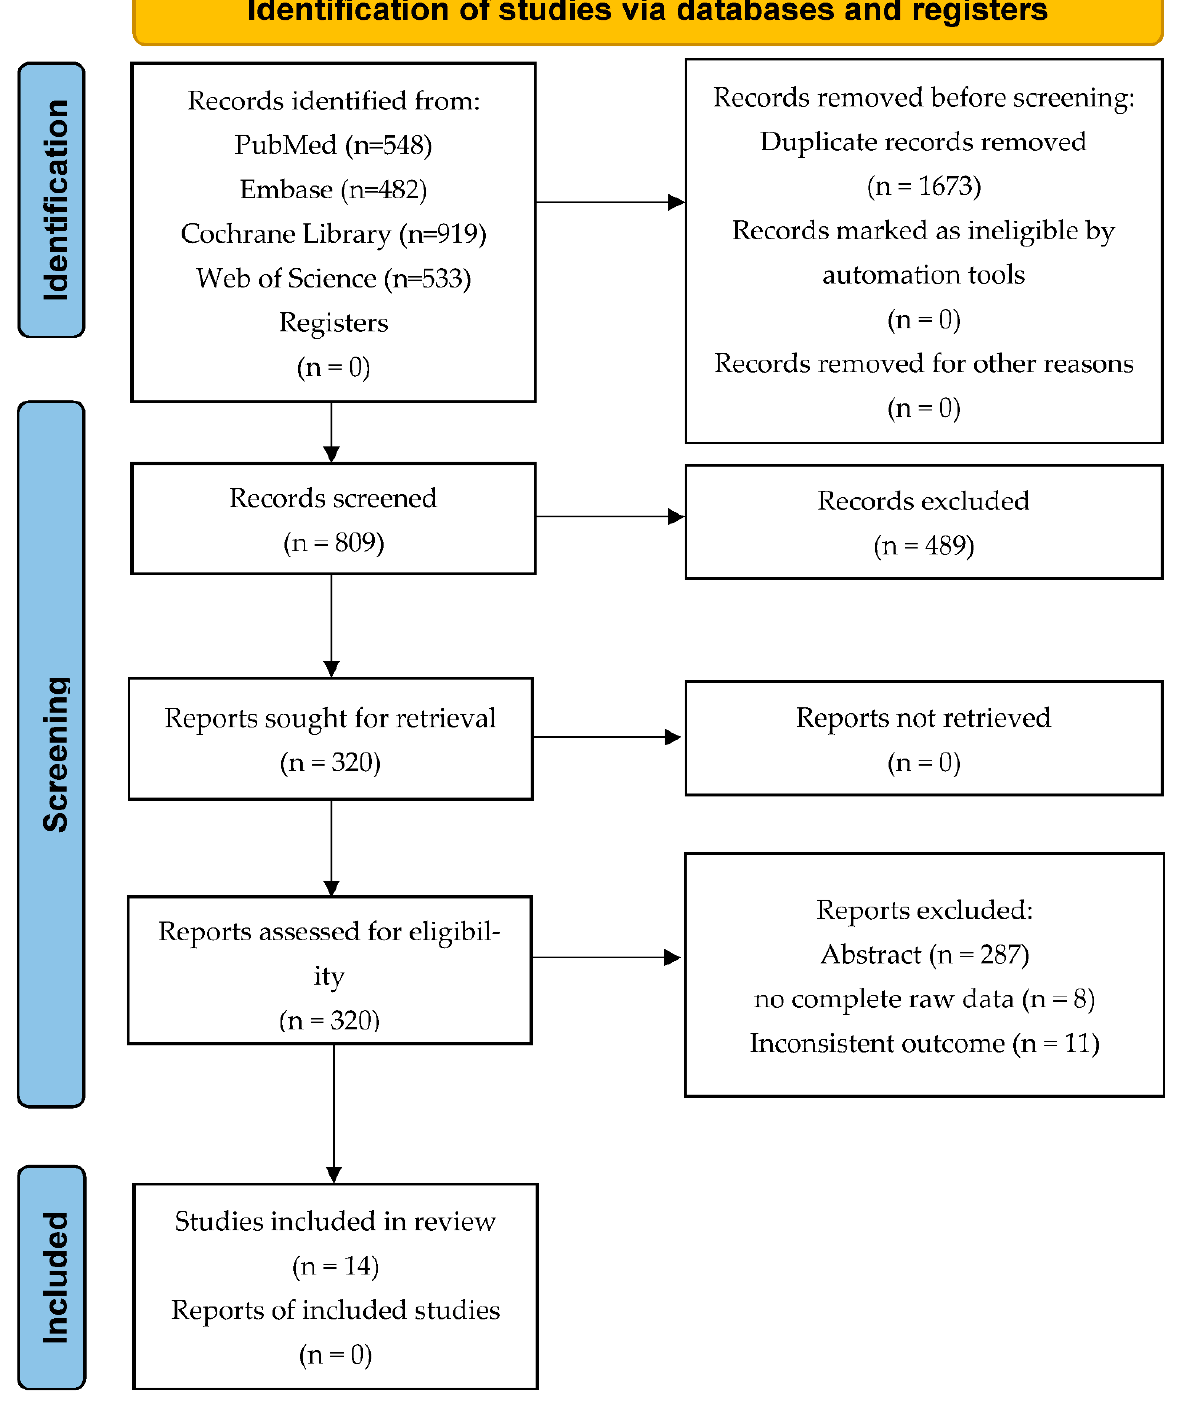
Figure 1. PRISMA flow diagram for search strategy and study selection.